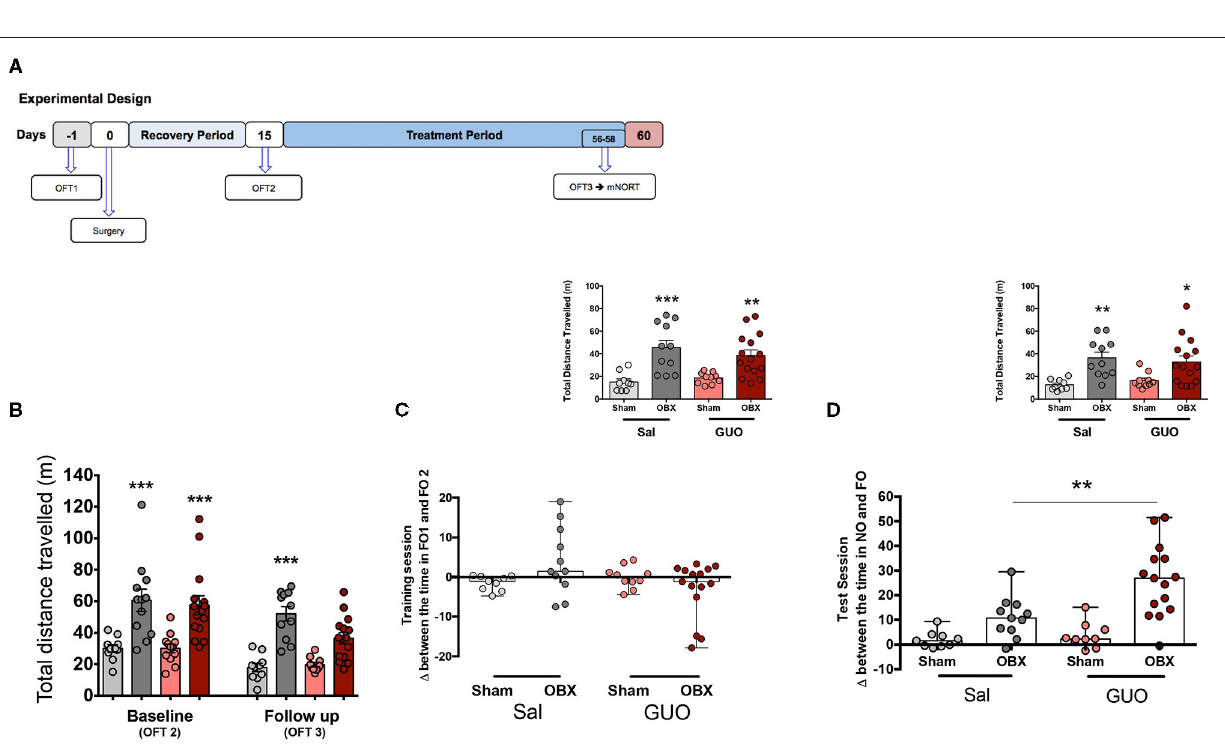
FIGURE 2 | Cohort 2: study design (A) . Surgery and GUO treatment effects in locomotor activity in OFT (B) . Columns represent mean ± S.E.M. ( n = 10–15). * p < 0.05, *** p < 0.001 OBX x Sham, two-way ANOVA/Tukey. Effects of surgery and GUO treatment at mNORT training (C) and test (D) sessions. Columns represent median with range, and in the inserts, columns represent mean ± S.E.M. ( n = 10–15). ** p < 0.001; total exploratory behavior, two-way ANOVA/Sidak. Inserts represent distance travelled. * p < 0.05, ** p < 0.001, *** p < 0.0001 two-way